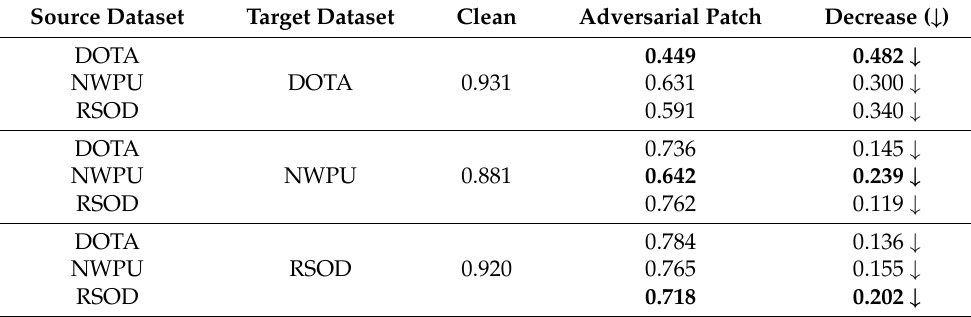
Table 3. Scenario A: Attack transferability of dataset-to-dataset.